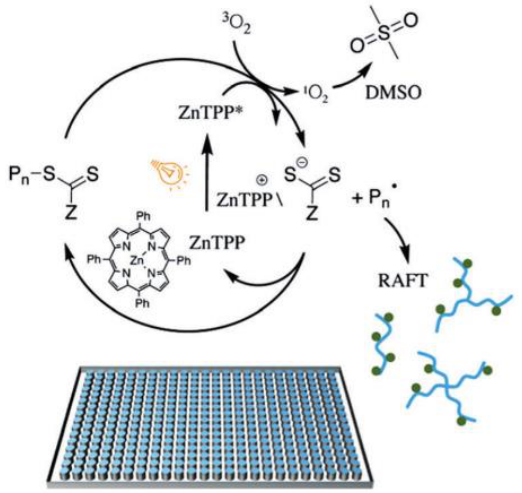
Figure 9. Ultralow volume PET-RAFT polymerization without any prior deoxygenation step and direct investigation on protein binding. Reproduced with permission from ref. [65]. *: excited state.